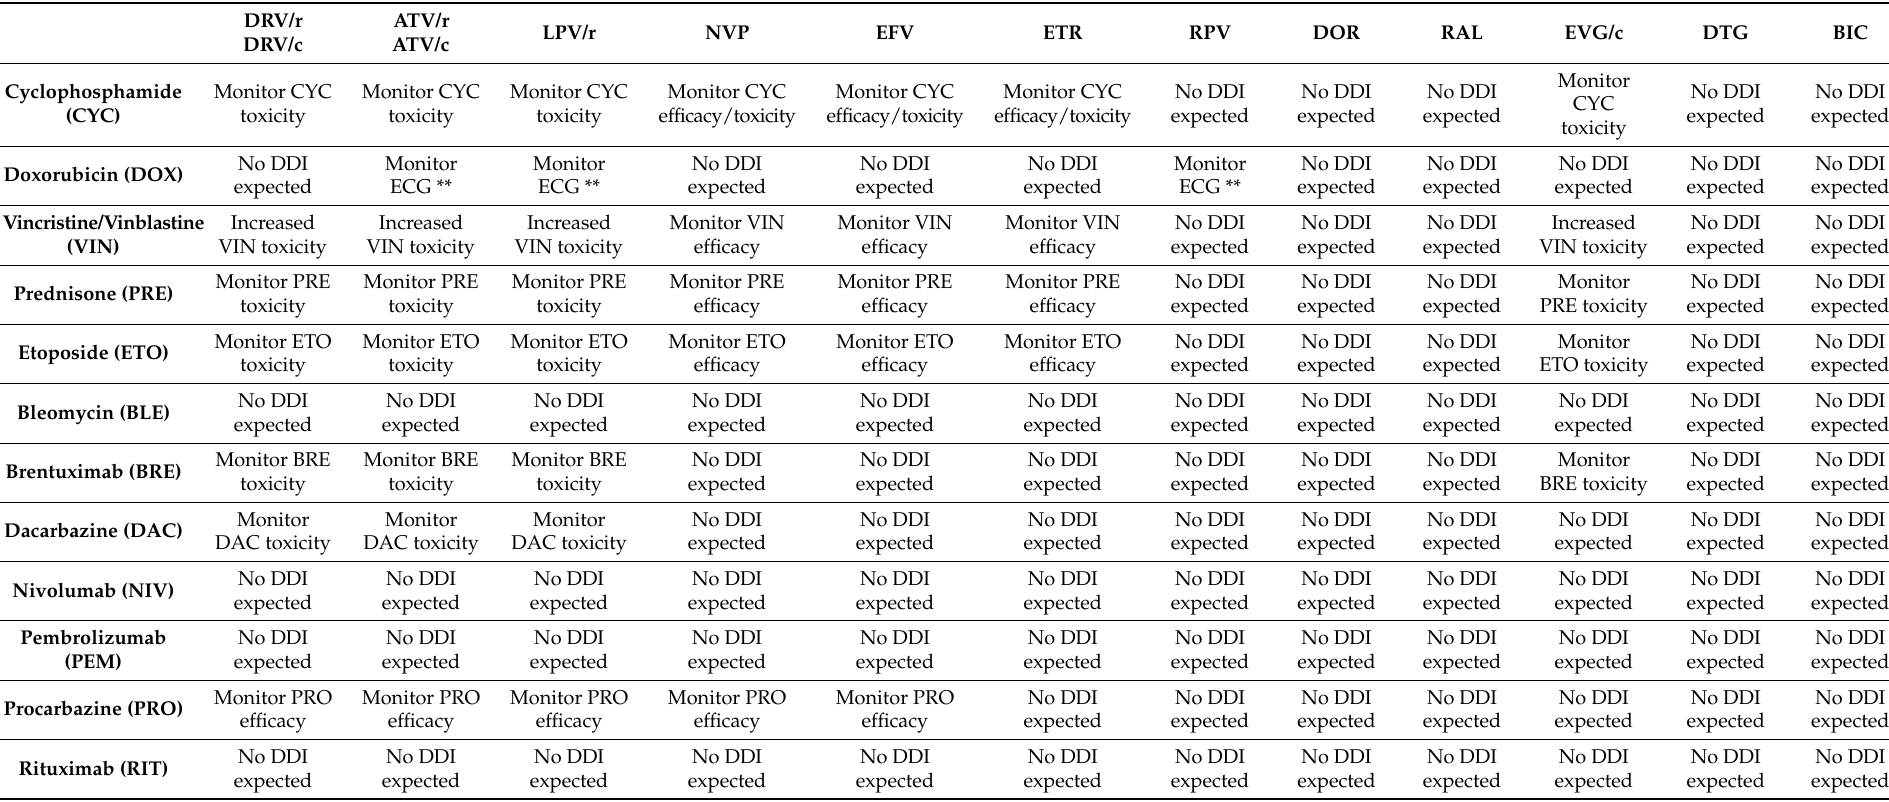
Table 2. Main drug–drug interactions (DDI) between drugs for the treatment of Hodgkin lymphoma and antiretroviral agents (www.hiv-druginteractions.org; www.hivclinic.ca/main/ drugs_interact.html accessed on 30 May 2021)